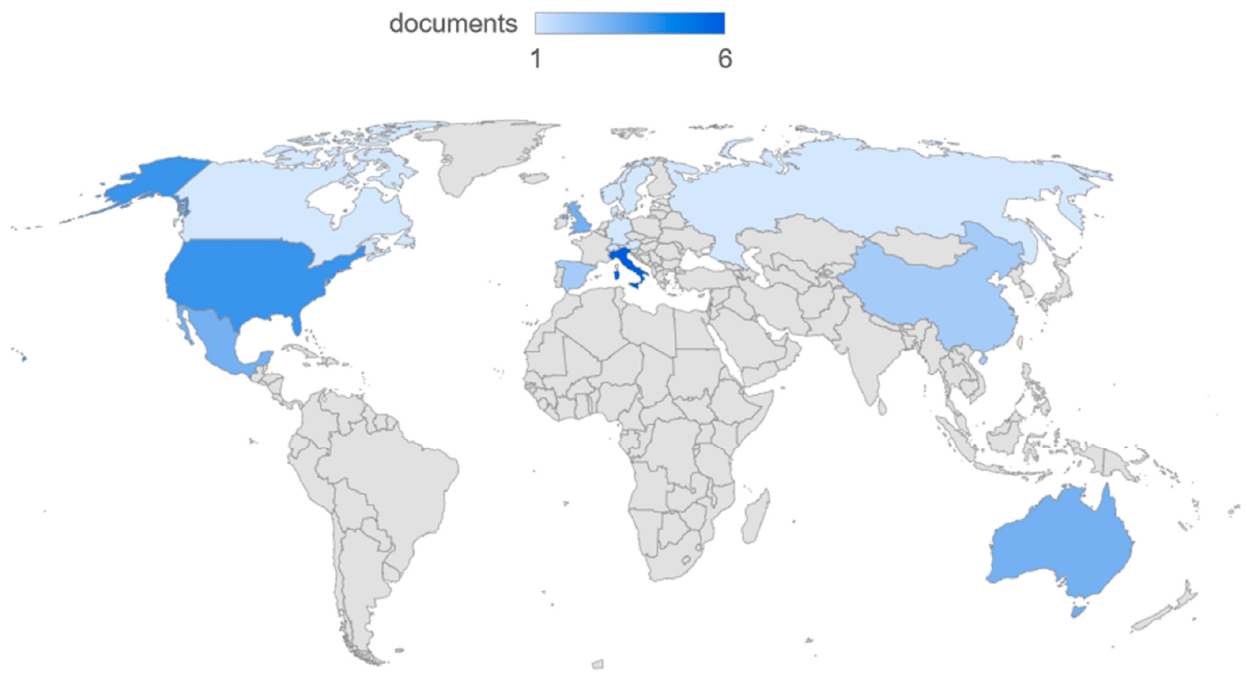
Figure 3. Distribution of publications by country. The absolute number of citations for each publication was also analyzed. The ten most cited articles are presented in Table 1. Table 1. Top 10 cited articles.